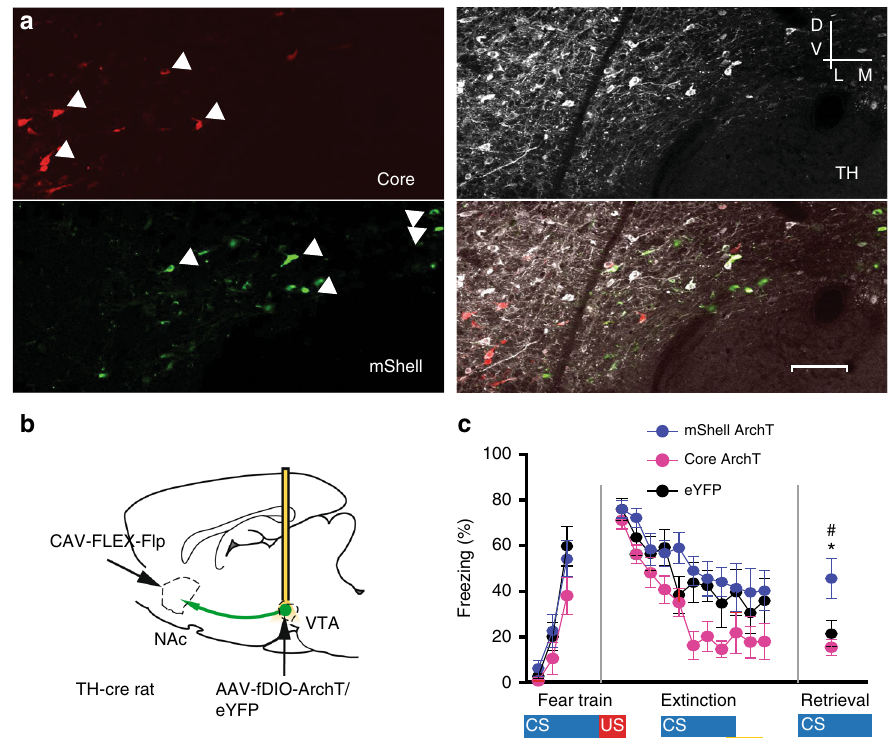
Fig. 4 VTA-dopamine neurons projecting to NAc mShell facilitate consolidation of extinction learning. a Double retrograde tracer injections into NAc labeled unique populations of mShell (green, lower left) and core (red, upper left) projecting VTA-dopamine neurons (TH labeled, white, upper right). Overlay at bottom right. Arrowheads denote retrogradely labeled/TH + cells. b Schematic of optogenetic viral approach for inhibiting NAc mShell or core projecting VTA-dopamine neurons. Retrograde CAV-FLEX- fl p (cre-dependent fl p) virus injection into NAc mShell or core and AAV-fDIO-ArchT/eYFP or AAV-fDIO-eYFP ( fl p dependent) injections into VTA of TH-cre rat. Brain image adapted from ref. 70 . Copyright 1982, Elsevier. c Inhibition of mShell projecting VTA-dopamine neurons during shock omission period of extinction training reduced extinction memory retention. All groups extinguished equally ( F 20, 230 = 1.19, p = 0.26 interaction, two way repeated measures ANOVA), but freezing was signi fi cantly higher at the “ retrieval ” time-point in the mShell projecting group ( n = 9, green) compared to both core projecting ( n = 8, red) and eYFP ( n = 9, black) groups ( F 2, 24 = 5.620, p = 0.010 one-way ANOVA, * and # denote signi fi cant differences between mShell group and both core and eYFP groups using Holm – Sidak posthoc tests). Error bars